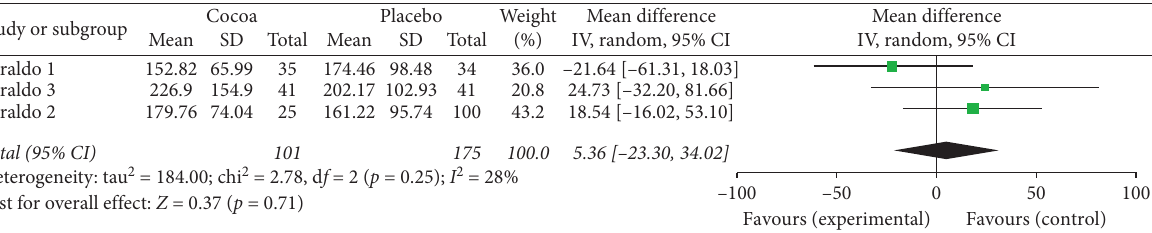
Figure 5: Meta-analysis of the effect of cocoa consumption on triglycerides as compared with placebo. The sizes of the data markers indicate the weight of each study in the analysis. IV: inverse variance.